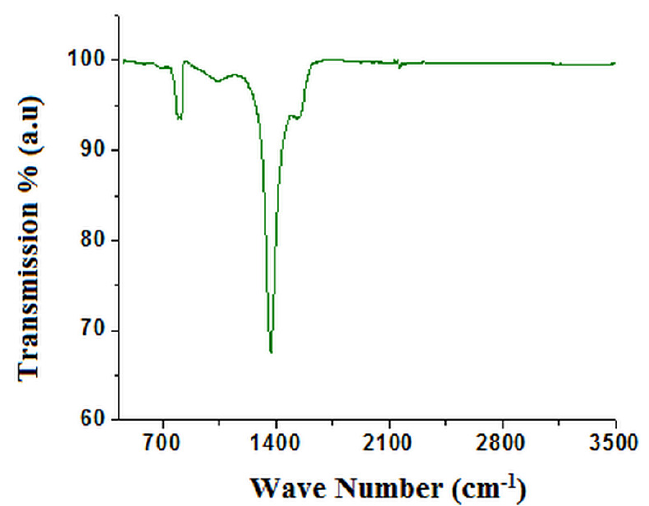
Figure 6. FTIR spectrum shows peaks correspond to “R” and L-mode of vibrations in 10